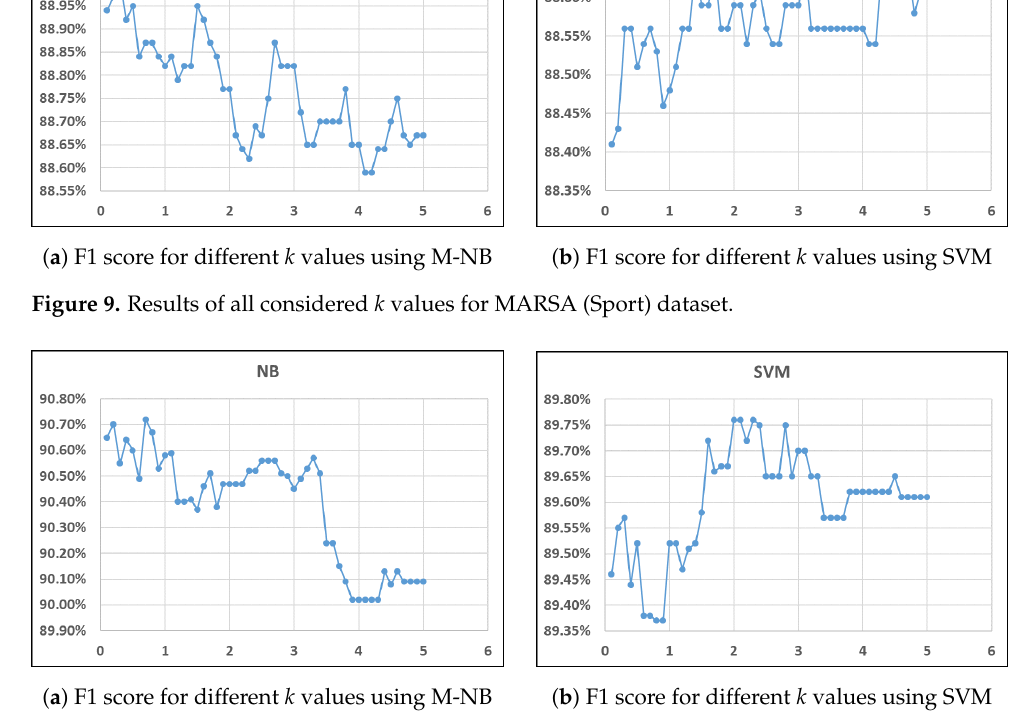
Figure 10. Results of all considered k values for Twitter airline sentiment